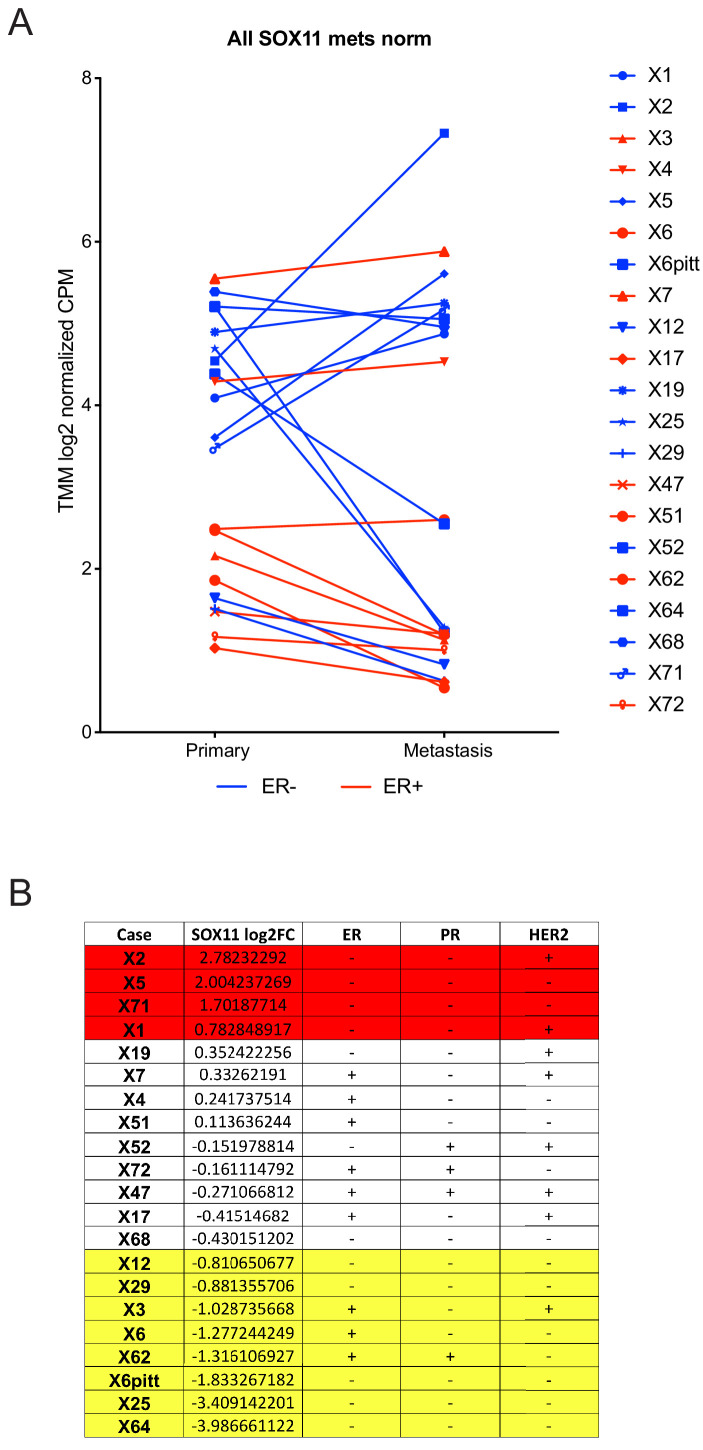
SOX11expression in breast cancer brain metastasis.(A) Graph showing the log2 values of SOX11 in primary tumours and its correlative log2 values in the brain metastasis dataset from Varešlija et al., 2019. (B) Table resuming the SOX11 log2 fold-change between the values in the brain metastasis and the primary tumour and the ER, PR and HER2 status of each case.